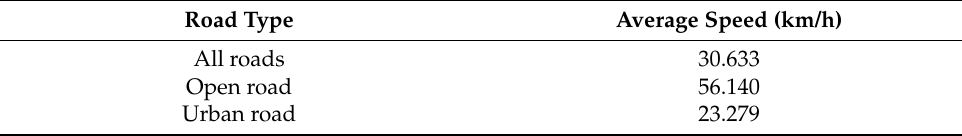
Table 3. Truck average speeds on open road and urban road, from GPS data.